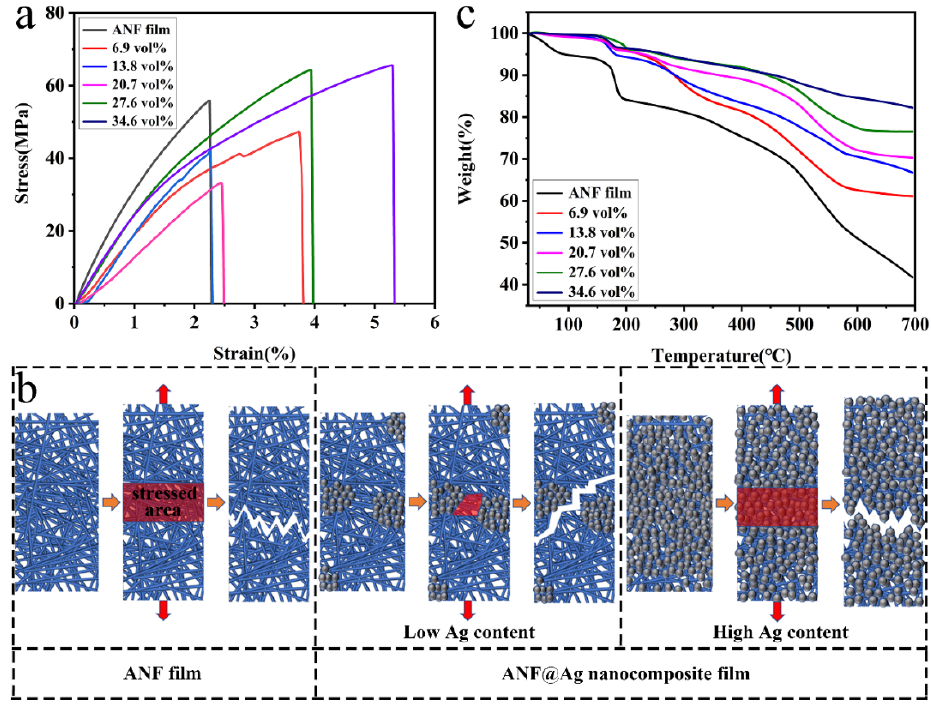
Figure 6. ( a ) Stress–strain curves of the ANF film and ANF@Ag nanocomposite films with different Ag contents; ( b ) schematic illustration of the fracture processes of the ANF film and ANF@Ag nanocomposite films; and ( c ) TG analysis of the ANF film and ANF@Ag nanocomposite films with different Ag content.